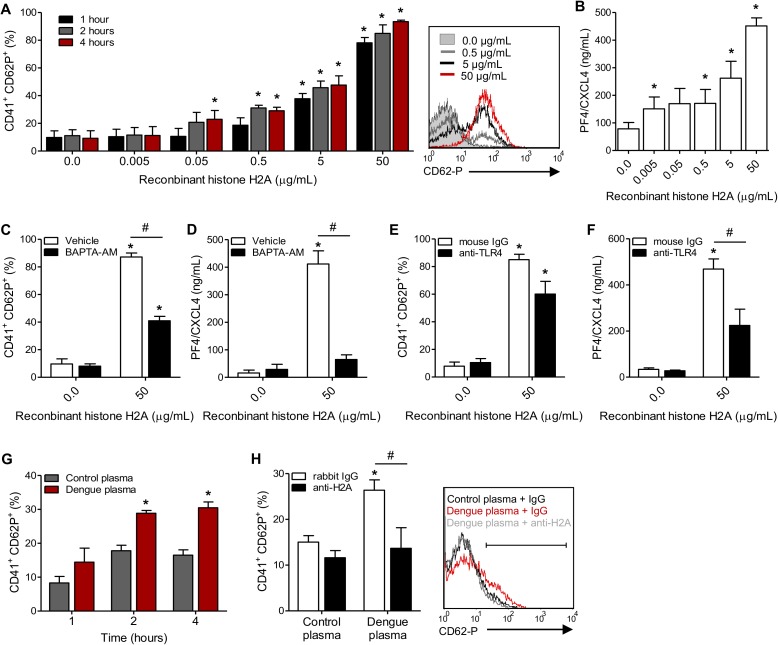
Circulating histone H2A in plasma from dengue-infected patients activates platelets.(A-B) Platelets isolated from healthy volunteers were stimulated with recombinant human histone H2A at the indicated concentrations. (A) Platelet surface P-selectin (CD62-P) was evaluated 1, 2 and 4 hours post stimulation by flow cytometry and (B) PF4/CXCL4 concentration was measured in supernatants 4 hours post stimulation. (C-F) Surface P-selectin and PF4/CXCL4 concentration in the supernatants of platelets stimulated with recombinant histone H2A for 2 hour in the presence of (C-D) the calcium chelator BAPTA-AM (20 μM) or vehicle (DMSO); or (E-F) blocking antibody against TLR4 (20 μg/mL) or isotype matched IgG. (G-H) P-selectin expression on platelets exposed to (G) plasma from six dengue-infected patients (dengue plasma) or four heterologous healthy volunteers (control plasma) for the indicated time-points; and (H) platelets exposed to dengue plasma or control plasma for 4 hours in the presence of anti-histone H2A (20 μg/mL) or isotype matched IgG. Bars represent mean ± standard error of the mean of 3 independent experiments (A-F) and of 4 to 6 independent plasma donors (G-H). * indicates p<0.05 compared to control plasma or unstimulated platelets; # represents p<0.05 between platelets treated with BAPTA-AM and vehicle or plasma samples treated with anti-histone H2A or isotype matched IgG. Representative histograms (A and H) illustrate surface P-selectin on platelets four hours after stimulation.